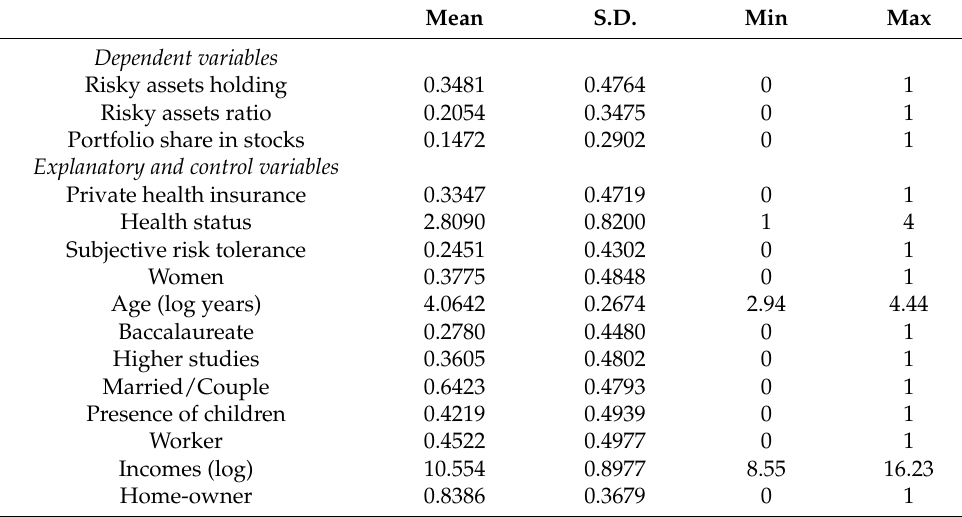
Table 2. Summary statistics.